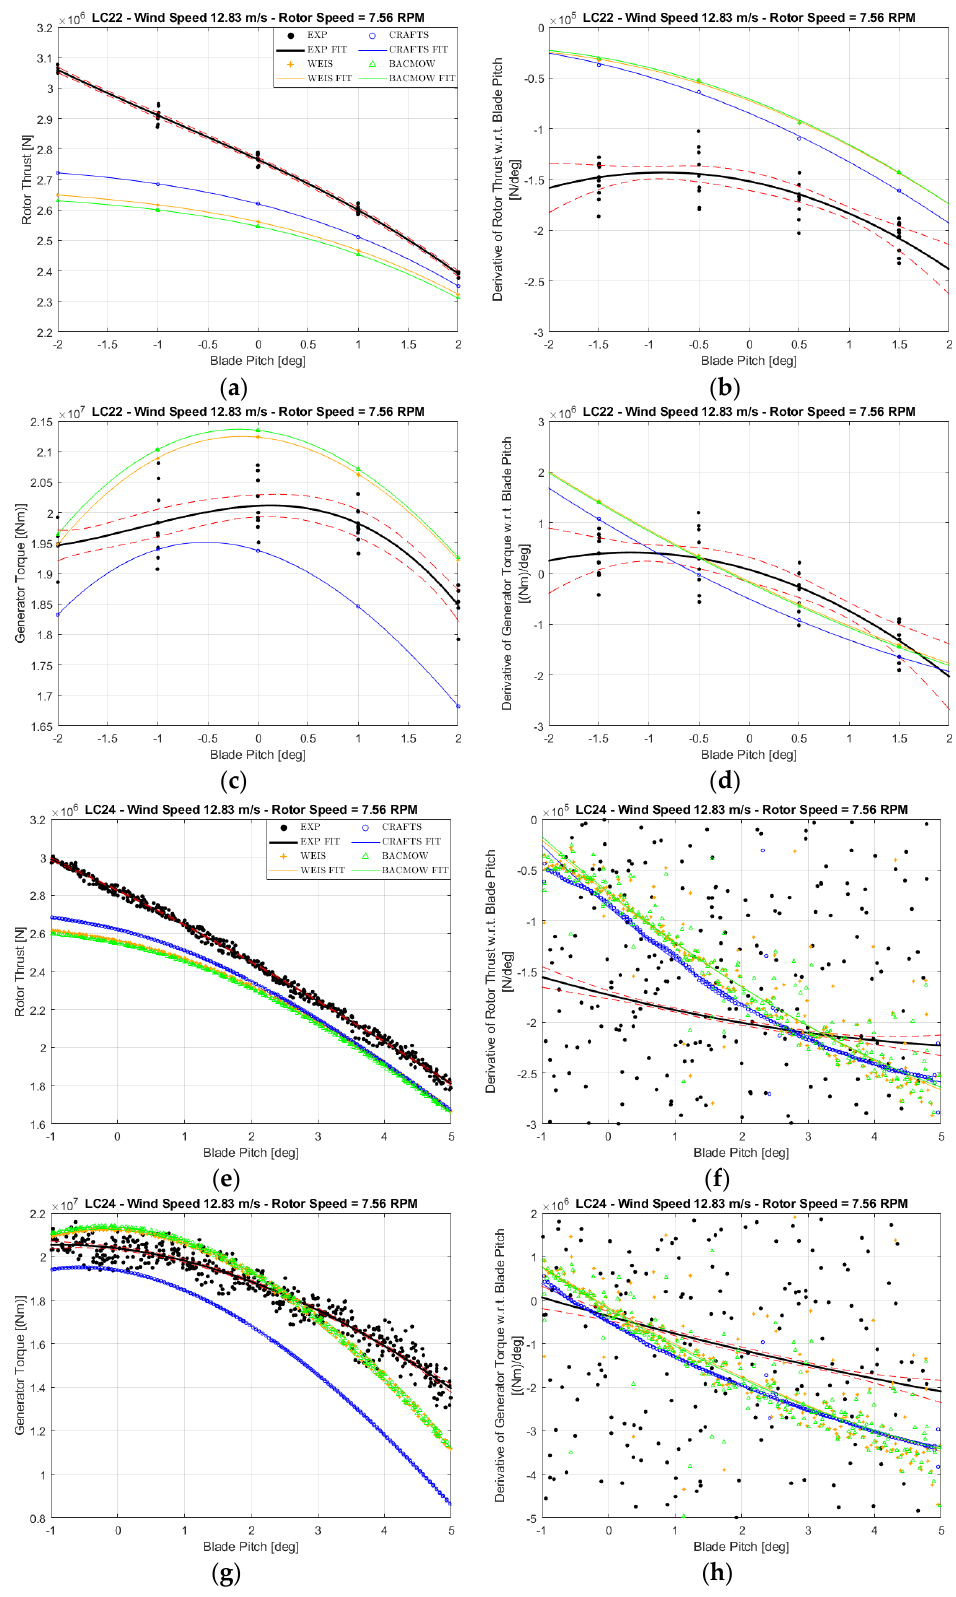
Figure 8. LC 2.2 and LC 2.4 thrust and torque sensitivities: ( a ) LC 2.2 thrust; ( b ) LC 2.2 derivative of thrust; ( c ) LC 2.2 torque; ( d ) LC 2.2 derivative of torque; ( e ) LC 2.4 thrust; ( f ) LC 2.4 derivative of thrust; ( g ) LC 2.4 torque; ( h ) LC 2.4 derivative of torque. The red dashed lines show the uncertainty of the true relation—not of individual data points—for only the experimental data.